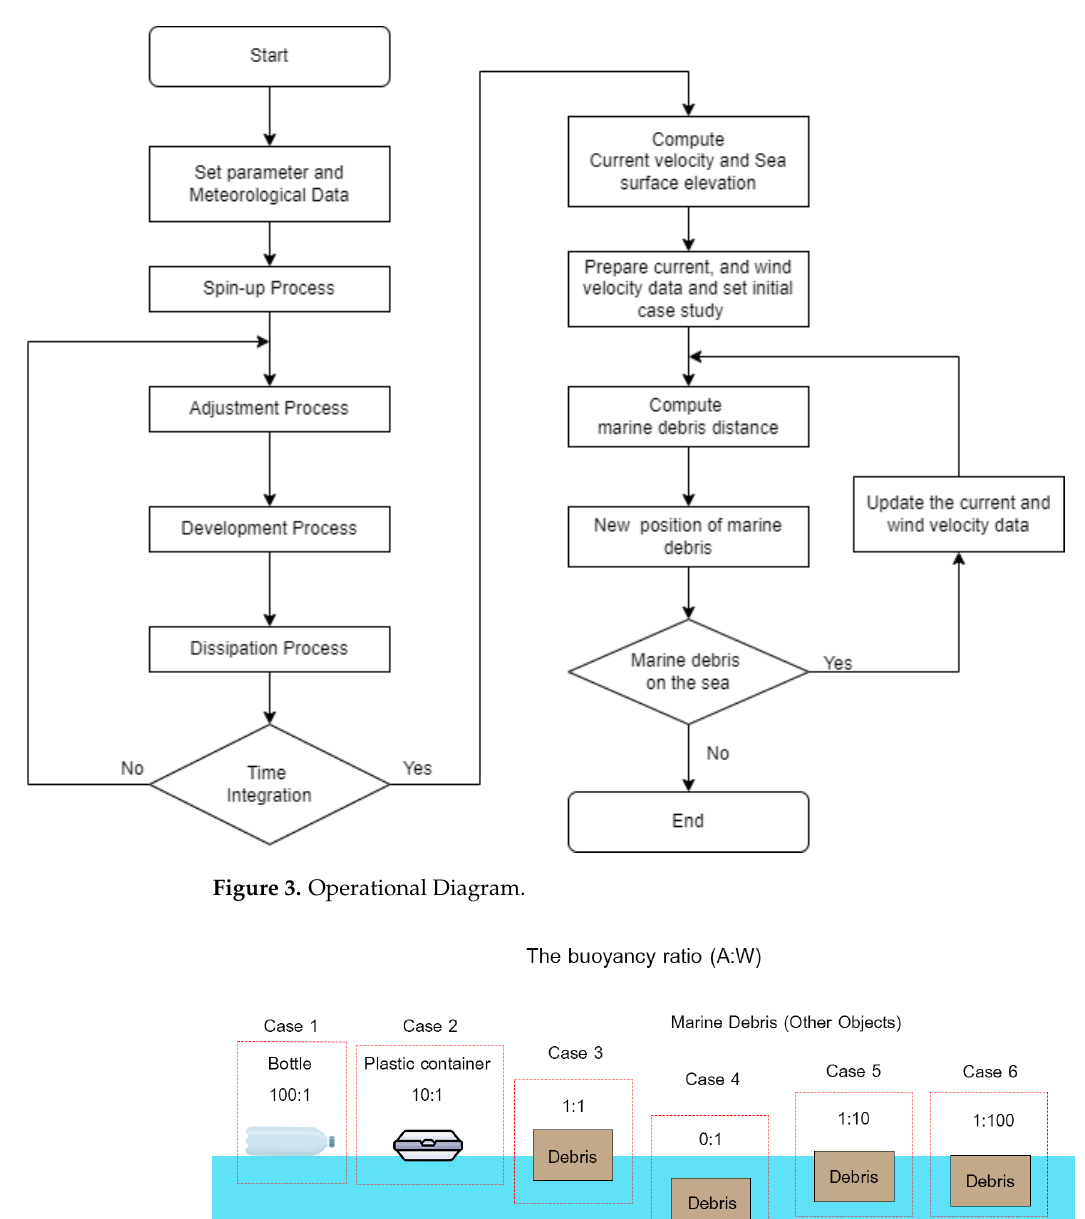
Figure 4. The buoyancy ratios with 6 cases are 100:1, 10:1, 1:1, 0:1, 1:10, and